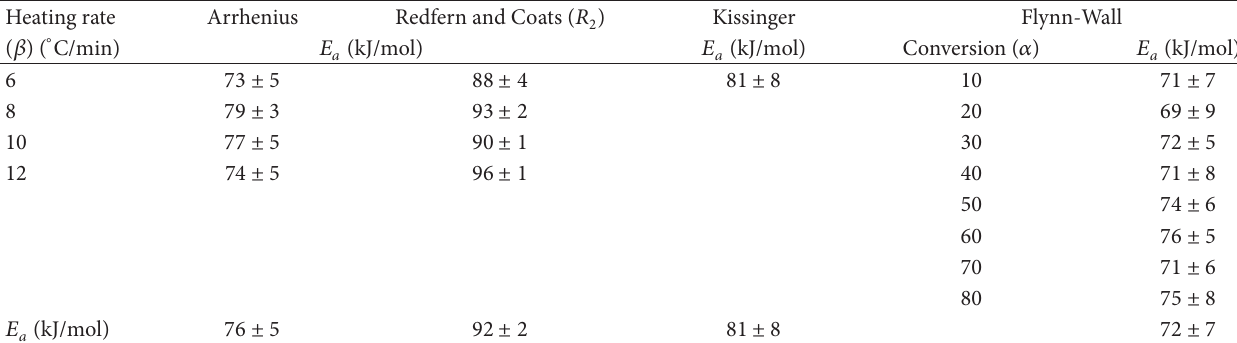
T 2: Isothermal sublimation kinetics of the Zr(tmhd)